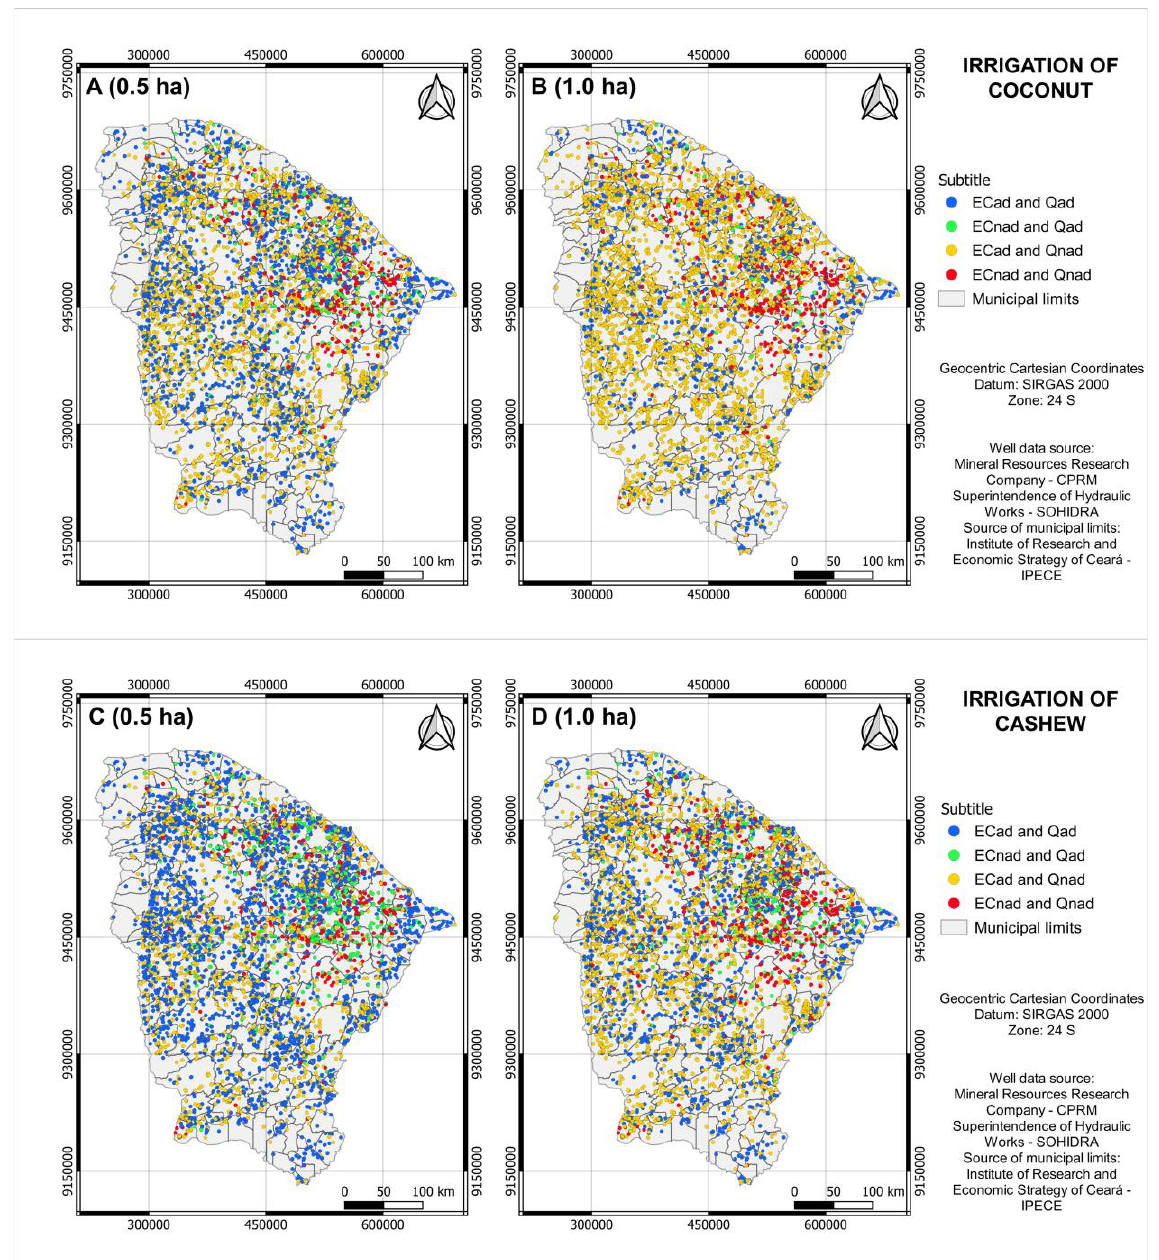
Figure 6. Potential of brackish groundwater in the State of Ceará (Northeast Brazil) for coconut irrigation in 0.5 ha ( A ) and 1.0 ha ( B ), and cashew irrigation in 0.5 ha ( C ) and 1.0 ha ( D ), based on the threshold electrical conductivity of the irrigation water (EC) and discharge rate (Q). EC ad : adequate electrical conductivity; EC nad : inadequate electrical conductivity; Q ad : adequate discharge; Q nad : inadequate discharge.